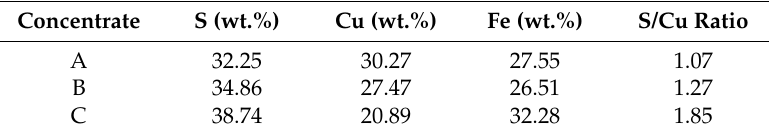
Table 2. Concentrates main proportional composed elements.